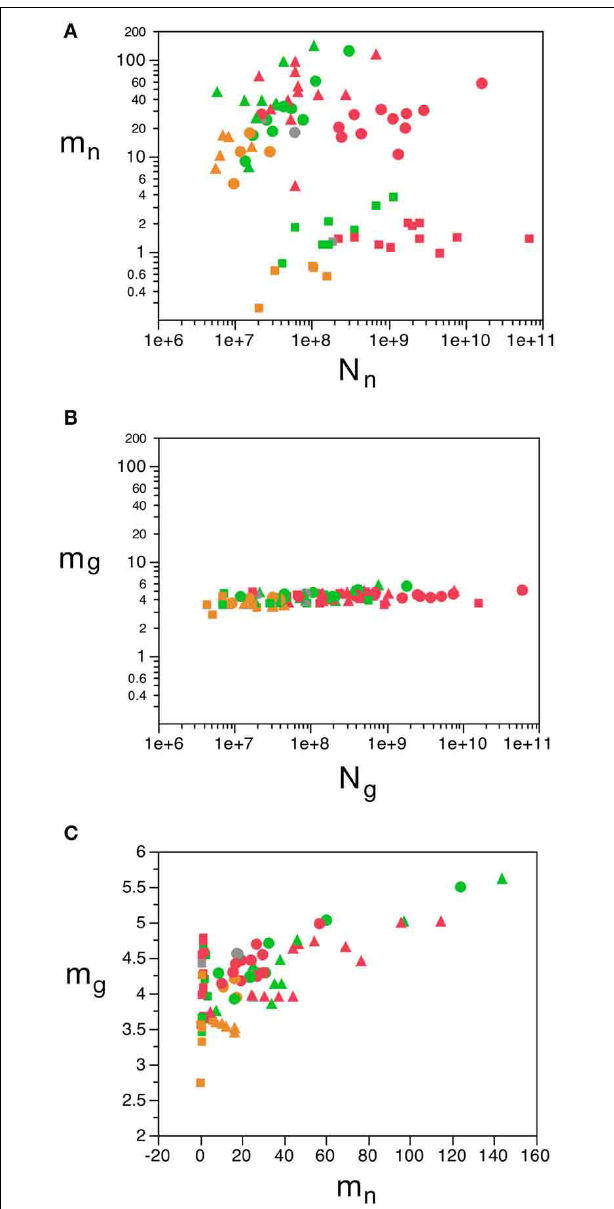
FIGURE 7 | Variation in predicted average neuronal and glial cell mass as a function of number of neurons and glial cells in the structure. (A) Estimated average neuronal cell mass ( m n ) for each brain structure in each species is plotted as a function of the total number of neurons in the structure ( N n ). (B) Estimated average glial cell mass ( m g ) for each brain structure in each species is plotted as a function of the total number of glial cells in the structure ( N g ). (C) Estimated average glial cell mass plotted as a function of estimated average neuronal cell mass in each brain structure and species. Cell mass given in picograms. Cerebral cortex plotted as circles, cerebellum as squares, and rest of brain as triangles; eulipotyphlans shown in orange, primates in red, and rodents in green. Graphs in (A,B) are plotted with identical scales for comparison, to illustrate the large variation in m n but small variation in m g . Data from Herculano-Houzel et al. (2006); Herculano-Houzel et al. (2007); Herculano-Houzel et al. (2011), Azevedo et al. (2009), Sarko et al. (2009), and Gabi et al. (2010).